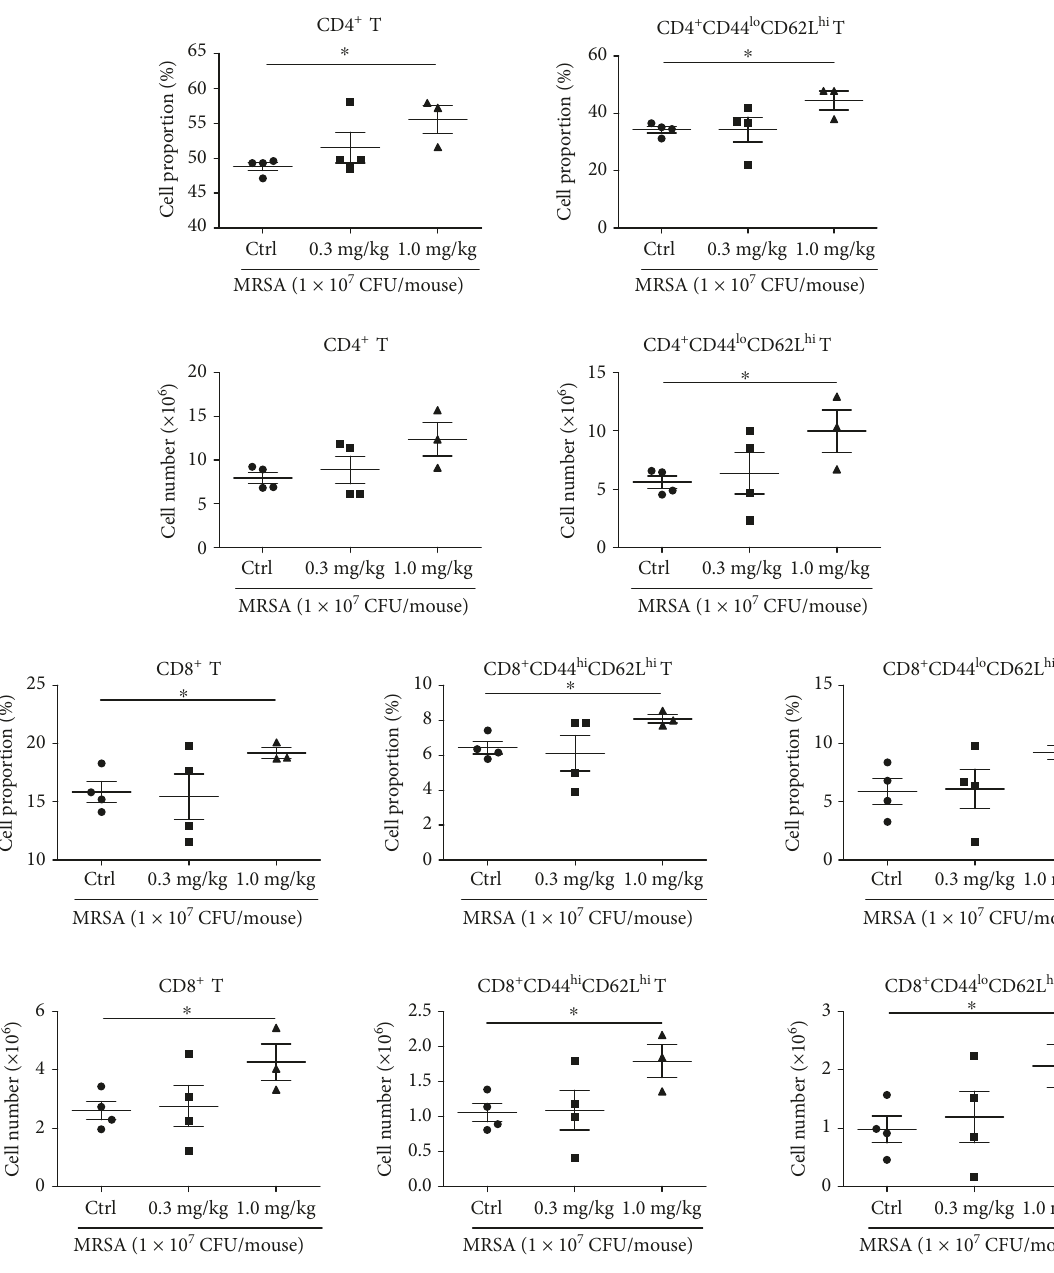
Figure 7: E ff ects of sublancin on the immune cell subset in the mesenteric lymph nodes (MLNs) of MRSA-challenged mice. Mice were orally administered with sublancin (0.3 mg/kg or 1.0mg/kg) for 14 consecutive days before infection. Phenotypic analysis of single-cell suspensions collected from the MLNs (the MLNs were excised from the mice 36 hours after infection). The phenotype of CD4 + and CD8 + T cells was further characterized by the expression of CD44 and CD62L, cell surface receptors which are di ff erentially expressed on memory (CD44 hi CD62L hi ) and naïve (CD44 lo CD62L hi ) T cell